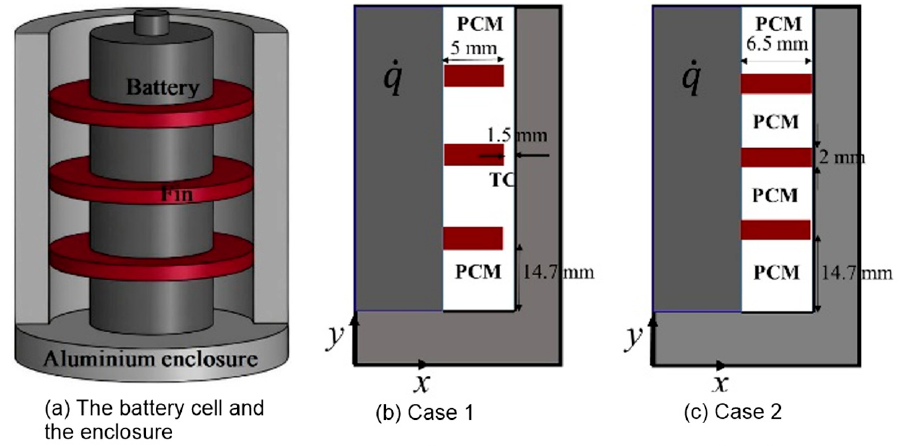
Figure 17. The setup considered in [67]. Reproduced with permission from Elsevier.